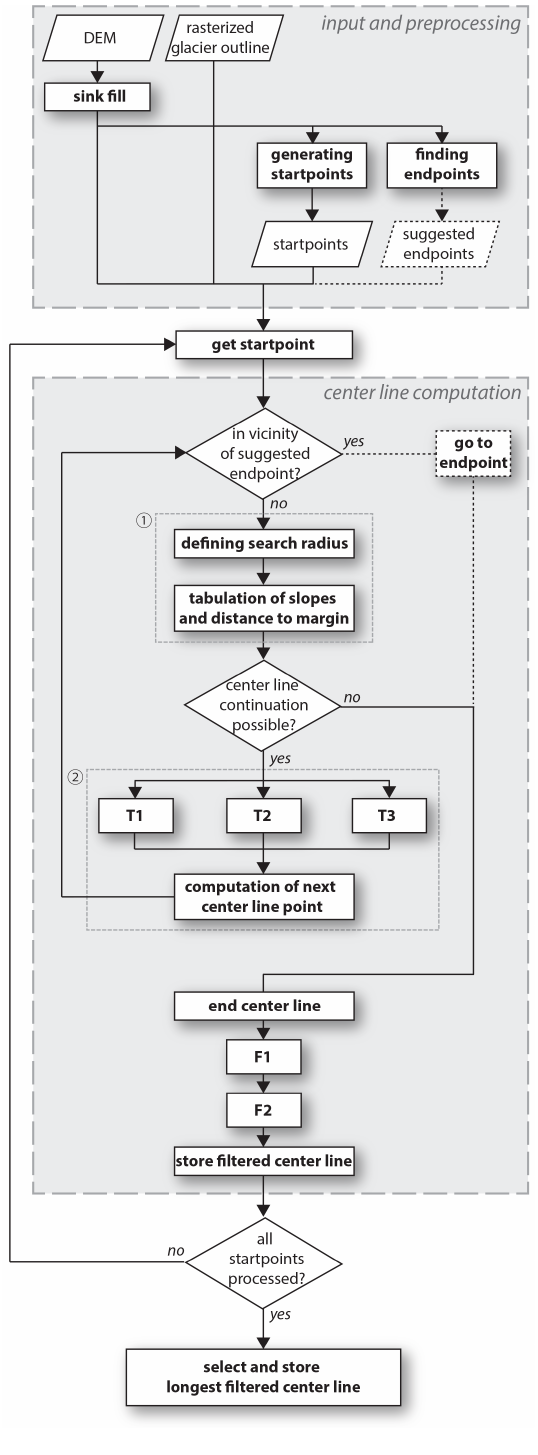
Figure 1. Flow chart illustrating the concept of center line compu- tation. T1, T2 and T3 refer to the three trade-off functions, F1 and F2 to the two filters. The symbols (1) and (2) relate to the visual- ized example in Fig. 2b. Dotted lines indicate operations related to suggested end points which are only computed for tide-water and lake-terminating